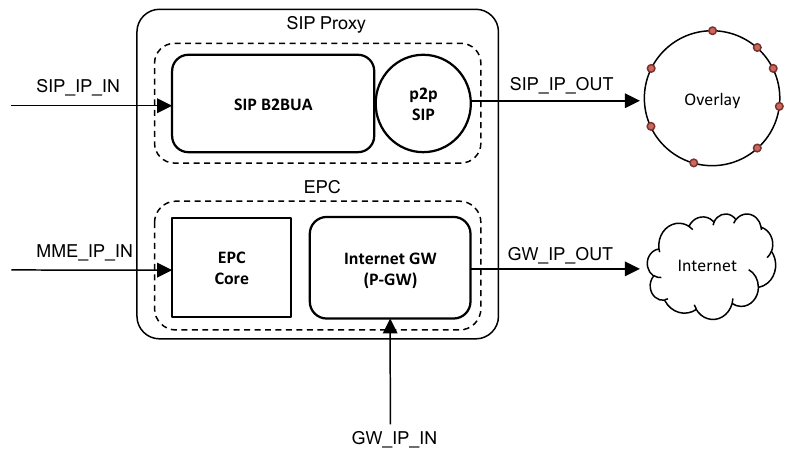
Figure 9. VCN high-level architecture (SIP Proxy and EPC are multi-homed).